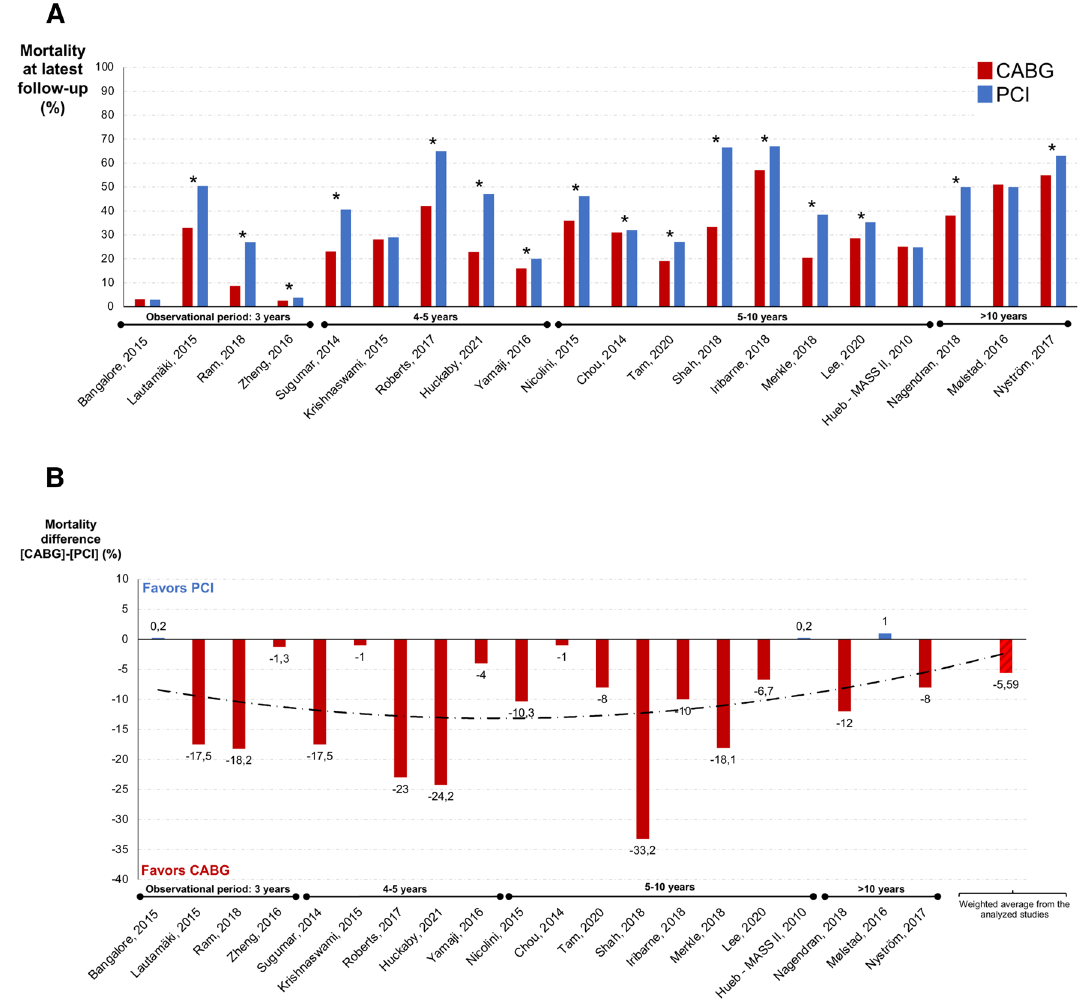
Figure 3. Actual mortality rates ( A ) and difference of the mortality rates in percentage ( B ) of the analyzed studies for PCI and CABG (excluding the non-risk-adjusted